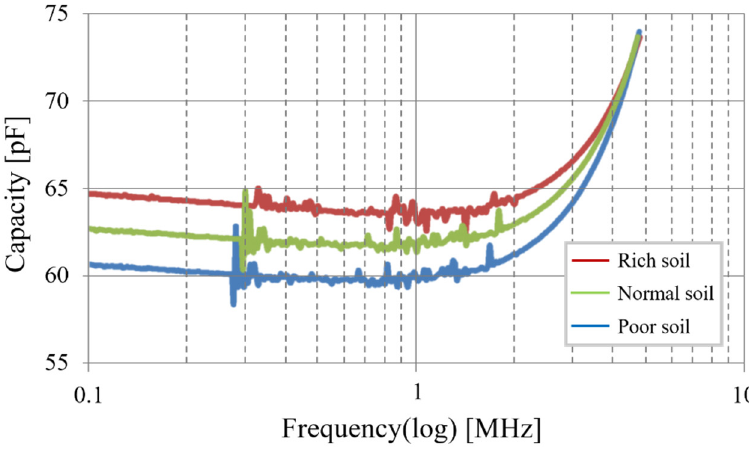
Figure 16. Sensor capacitance as a function of the frequency for different levels of salinity.